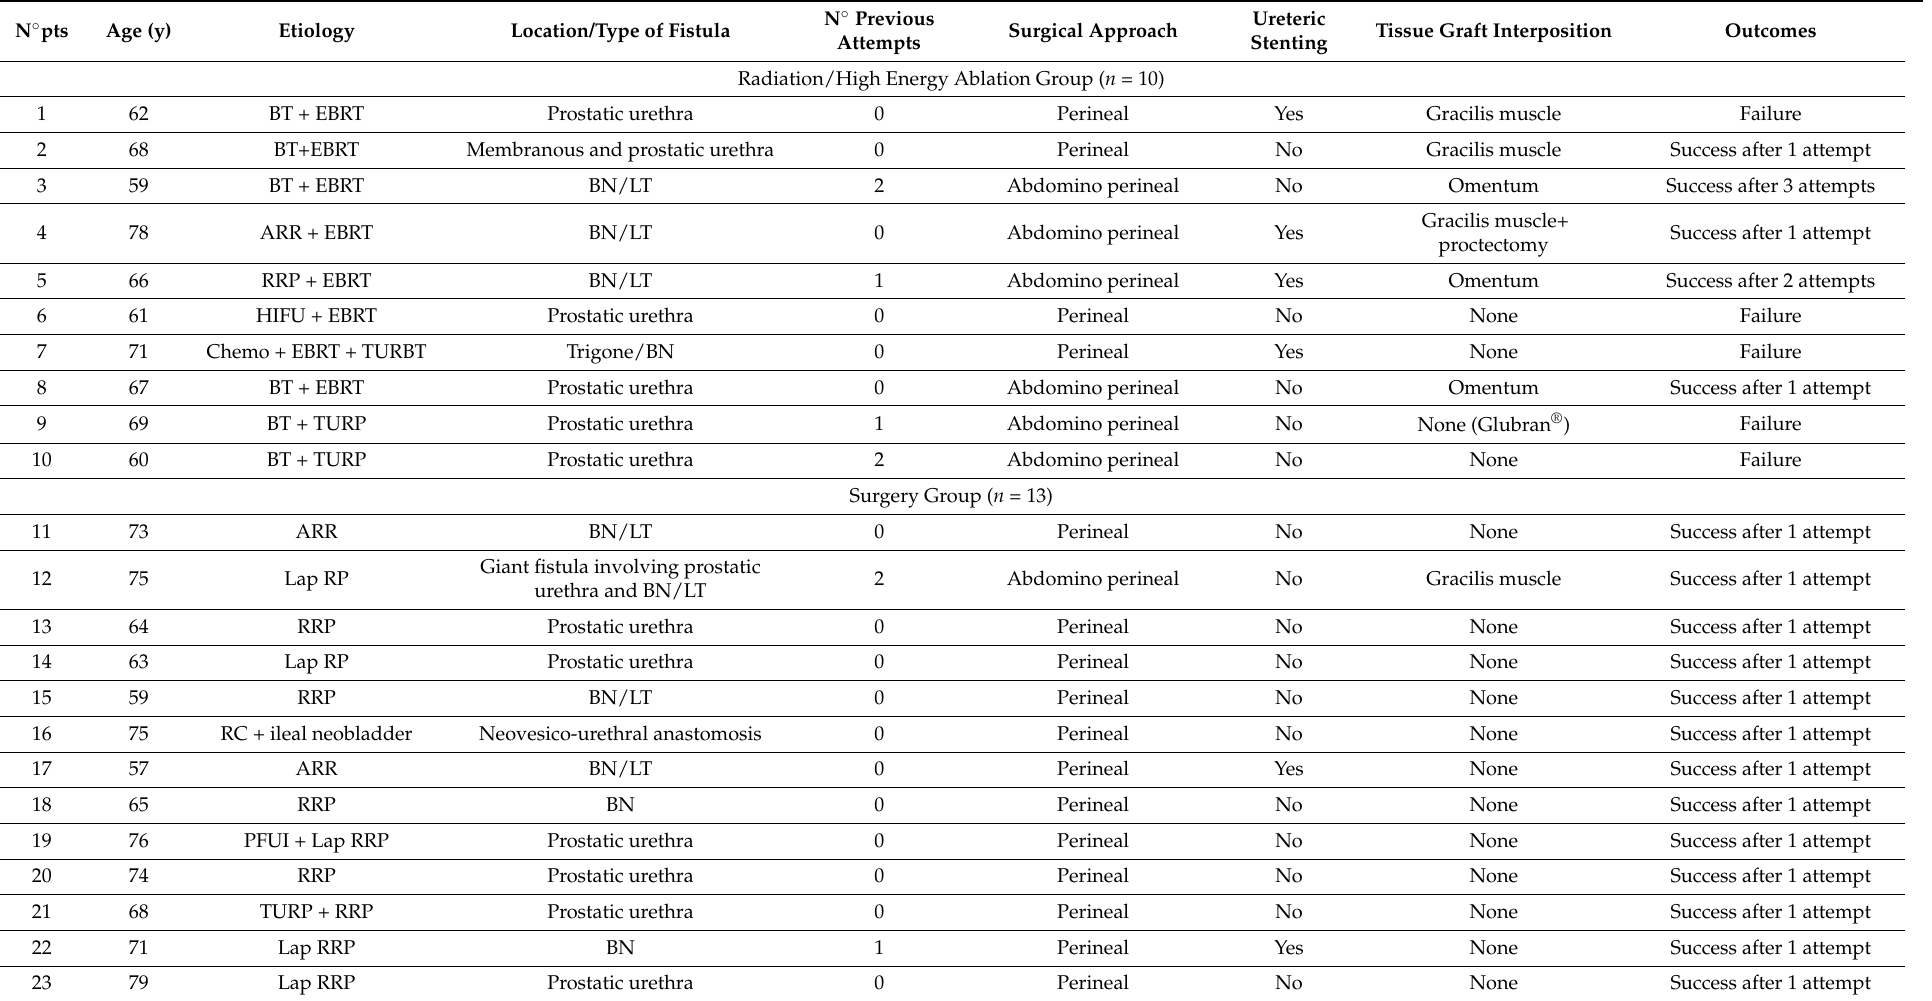
Table 1. Patient clinical demographics, surgical characteristics and